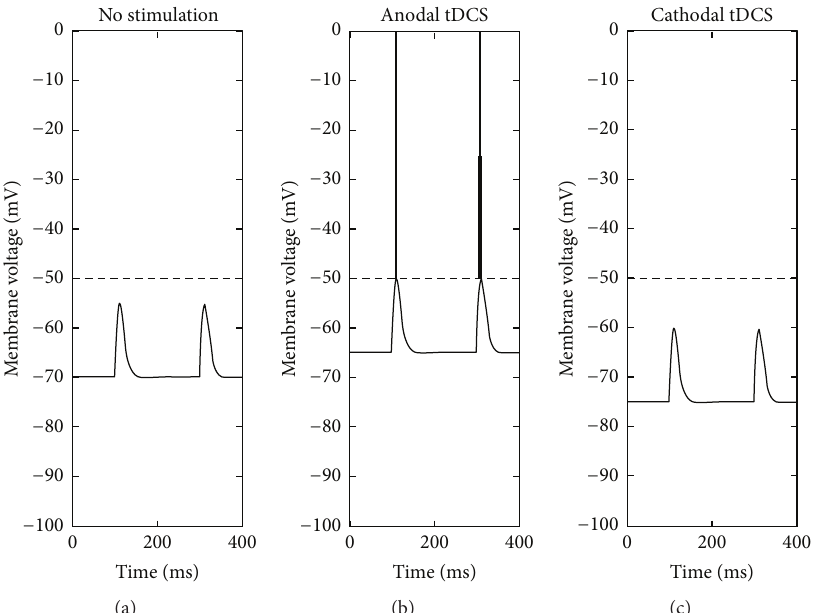
Figure 1: Assumed neural mechanism of tDCS. (a) Without tDCS, the resting potential of the cell is at − 70 mV and an incoming excitatory postsynaptic potential (EPSP) arriving 100ms after onset of the experiment does not reach the threshold for firing at − 50 mV (dashed line). (b) If the neuron is close to an anode, the positive voltage from the anode will raise the resting potential towards a more positive voltage and the same EPSP will exceed the threshold and result in a neural spike. (c) If the neuron is close to a cathode, the negative voltage from the cathode will lower the resting potential towards a more negative voltage and the same EPSP will not exceed the